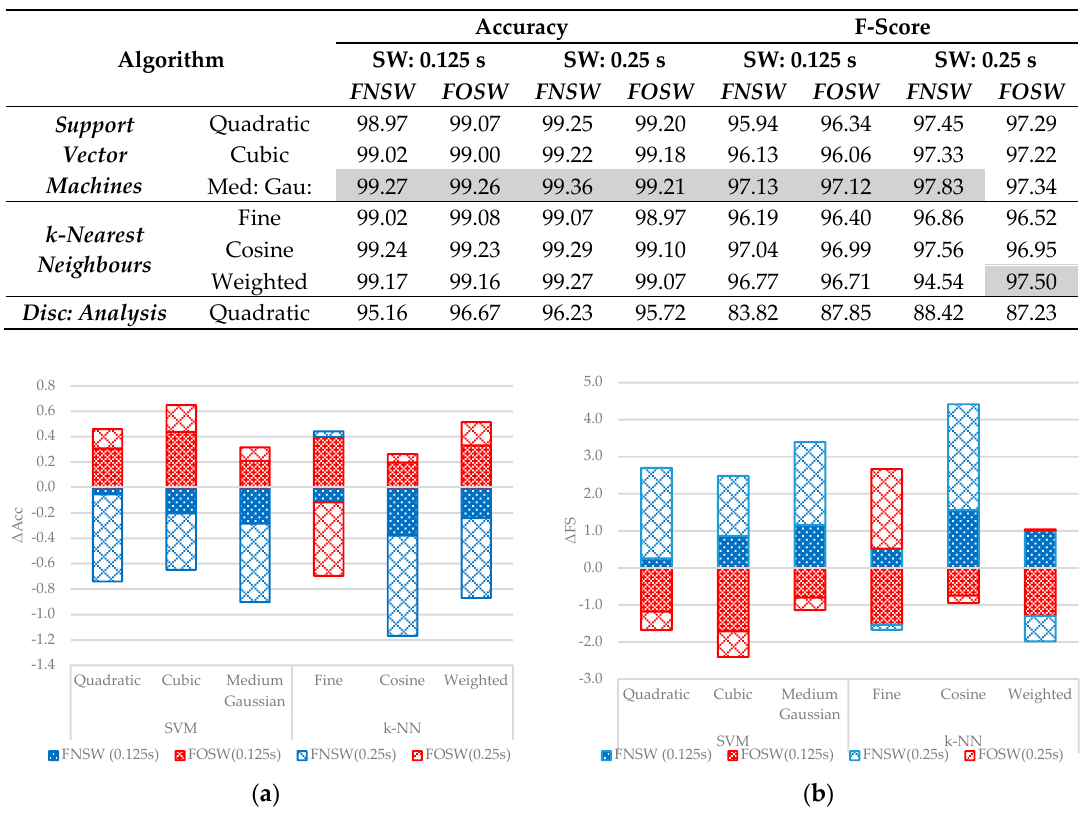
Figure 2. ( a ) Δ Acc and ( b ) Δ FS calculated for each classifier for different segmentation